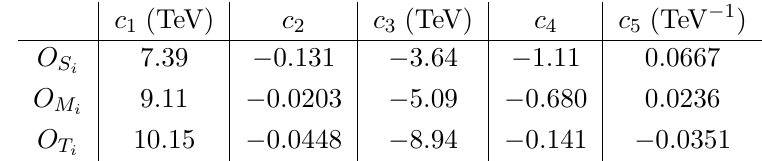
Figure 7 . The normalized distributions of | ∆ O S ( O M ) [ O T ]. i i i